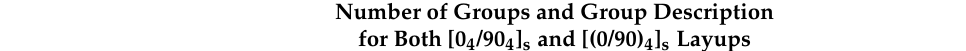
[( 0/90 ) ] s and s laminates and 4